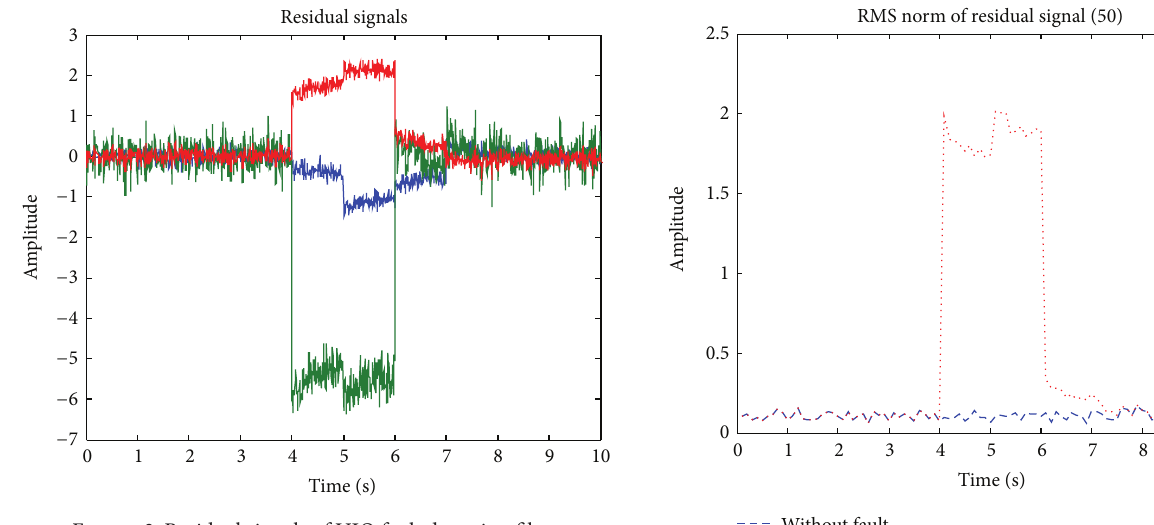
Figure 2: Residual signals of UIO fault detection filter.